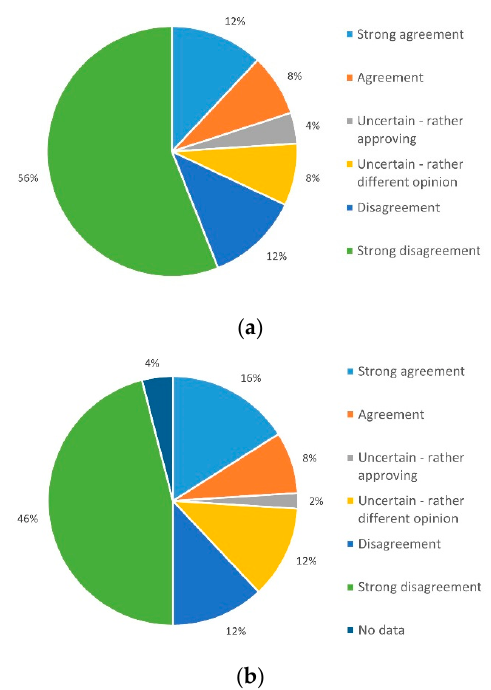
Figure 5. Expectation for problems of ( a ) privacy security issues and ( b ) daily use.